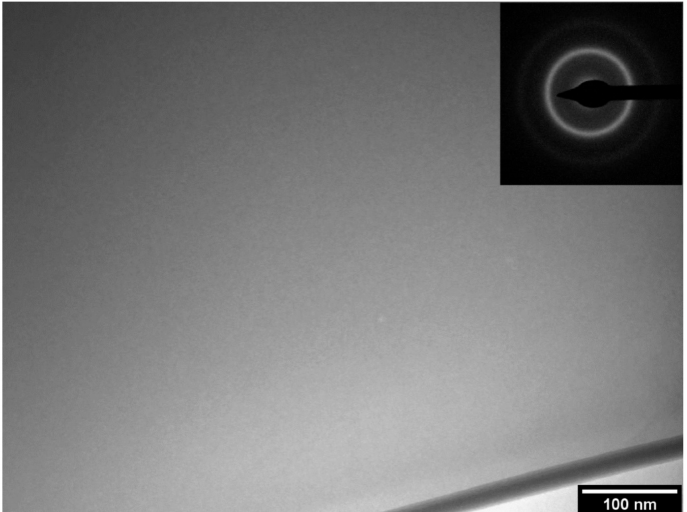
Figure 2. Bright field transmission electron microscopy (TEM) micrograph of the 63.5Fe25Cr7Ni4.5B ribbon obtained by melt-spinning and the selected electron diffraction pattern.